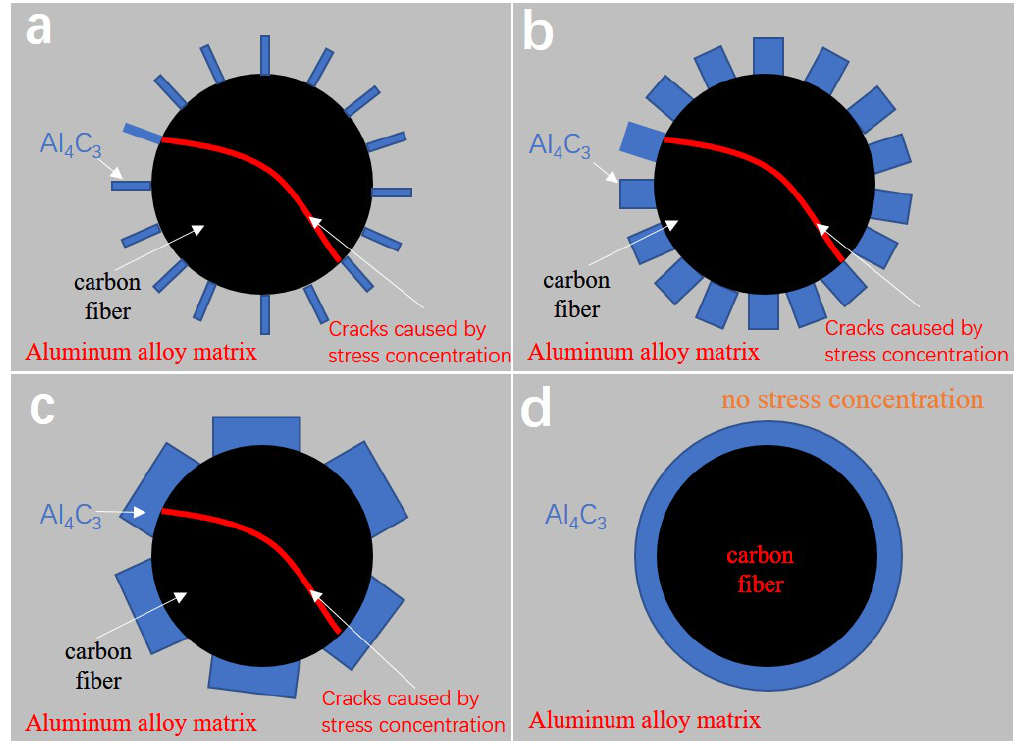
Figure 14. Schematic representation of Al 4 C 3. ( a ) Initial morphology of Al 4 C 3 ; ( b ). Morphology of coarsened Al 4 C 3 ; ( c ) Morphology of Al 4 C 3 connected together; ( d ) Al 4 C 3 layer completely covering carbon fiber surface.